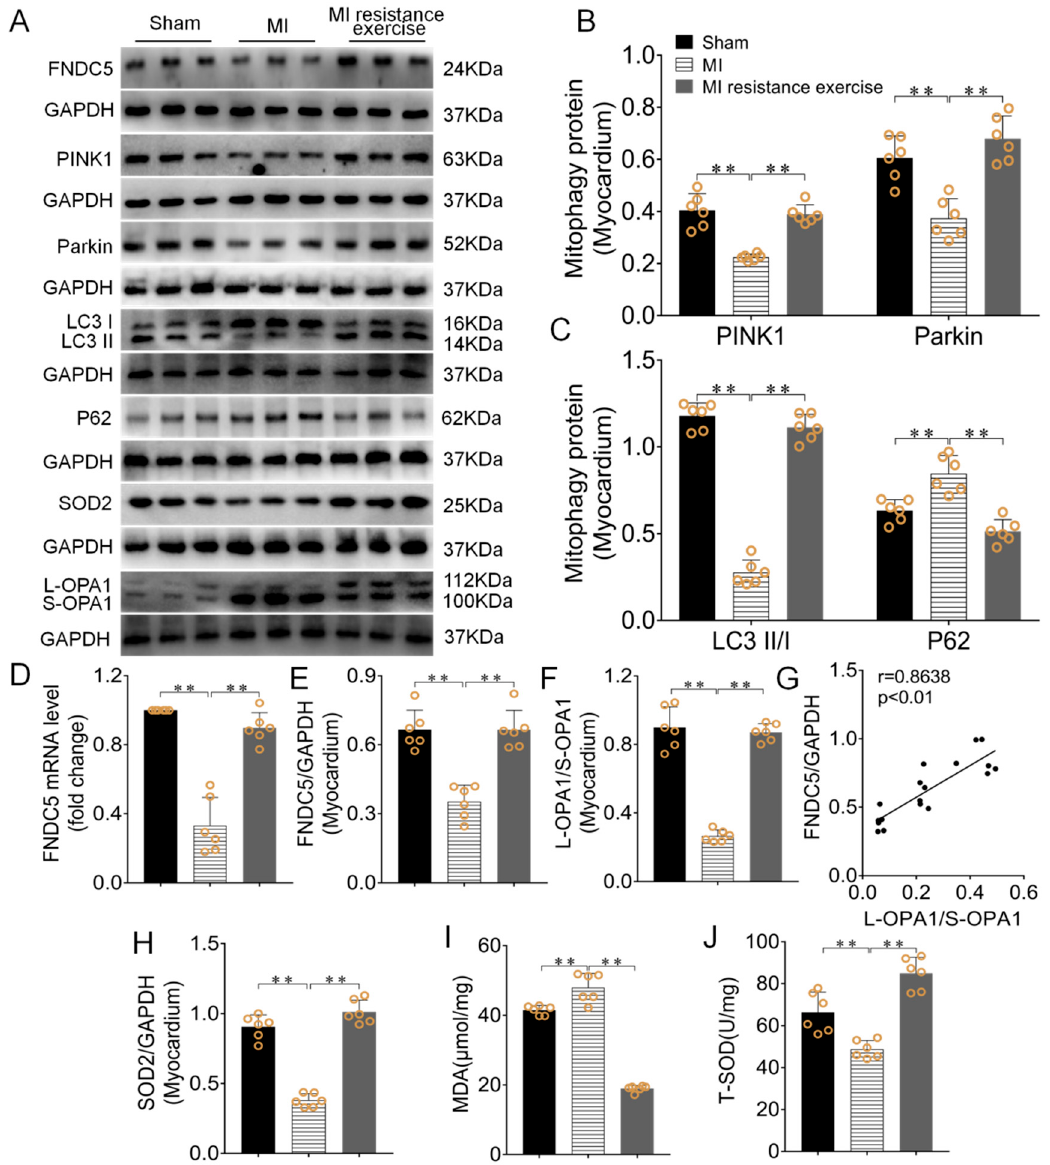
Figure 7. Resistance exercise enhanced MI myocardial irisin/FNDC5 expression, promoted mitophagy, enhanced antioxi- dative capability and alleviated the levels of oxidative stress. ( A – C , E , F , H ) The effect of resistance exercise on irisin/FNDC5, PINK, Parkin, P62, SOD2, protein expressions and L-OPA1/S-OPA1 and LC3II/I ratio in MI myocardium. ( D ) The effect of resistance exercise on Irisin/FNDC5 mRNA . ( G ) The Pearson correlation analysis between irisin/FNDC5 and OPA1 in MI myocardium. ( I , J )The changes of T-SOD and MDA in MI and MI resistance exercise groups. Data are expressed as mean ± SEM ( n = 6). ** p < 0.01. Abbreviations: FNDC5: transmembrane protein fibronectin type III domain protein 5, PINK1: PTEN-induced kinase 1, Parkin: E3 ubiquitin ligase parkin, LC3II/I: Microtubule-associated protein light chain 3, P62: SQSTM1/p62, OPA1: Optic atrophy protein-1, SOD2: Superoxide dismutase 2, MDA: Malondialdehyde, T-SOD: Total Superoxide dismutase.